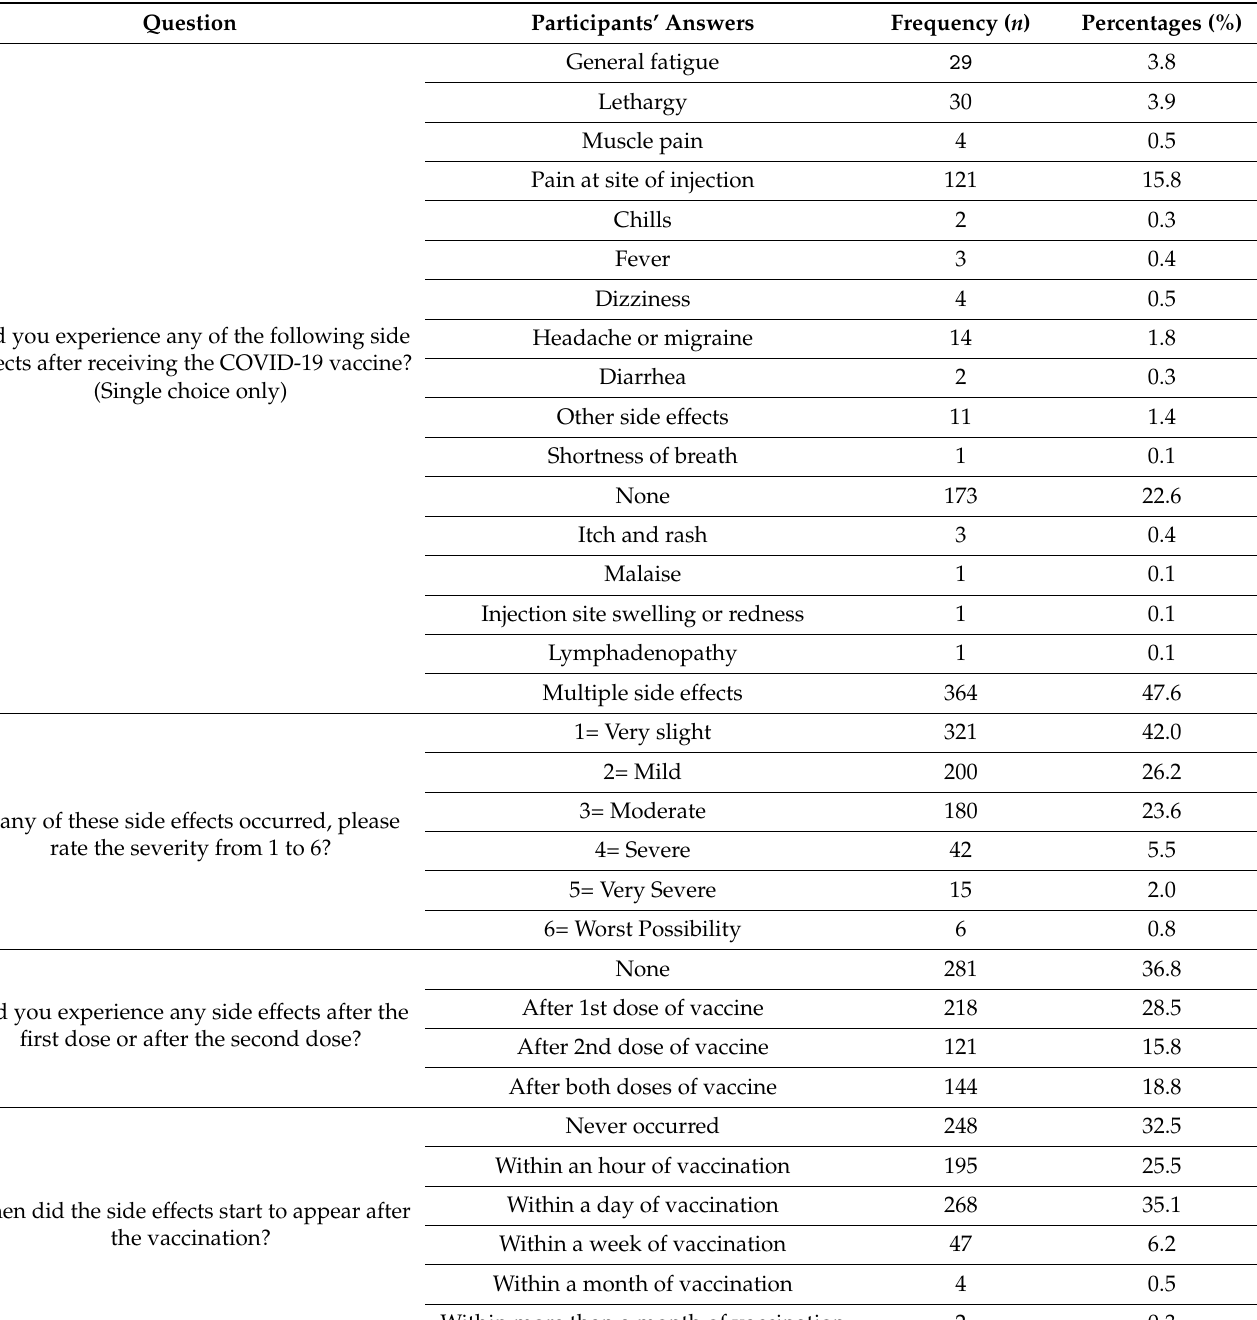
Table 4. Number and percentages of the questions assessing safety of the vaccines (total n =